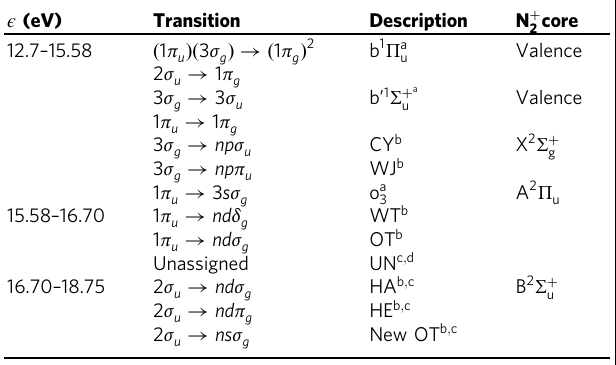
The experimental absorption spectrum of N 2 , shown in Fig. 2a, consists of numerous overlapping vibrational series associated with states of Rydberg and valence character. The absorptionfeaturesaresummarized bythephotonenergy ϵ ,thecolumn labeled “ Description"is the name of the electronic transitions in the “ Transition" column, the “ N 2 + core" column is the ionic state, to which the Rydberg series converge CY Carroll Yoshino, WJ Worley Jenkins, WT Worley third, OT Ogawa Tanaka, UN Unassigned, HA Hop fi eld absorption, HE Hop fi eld emission